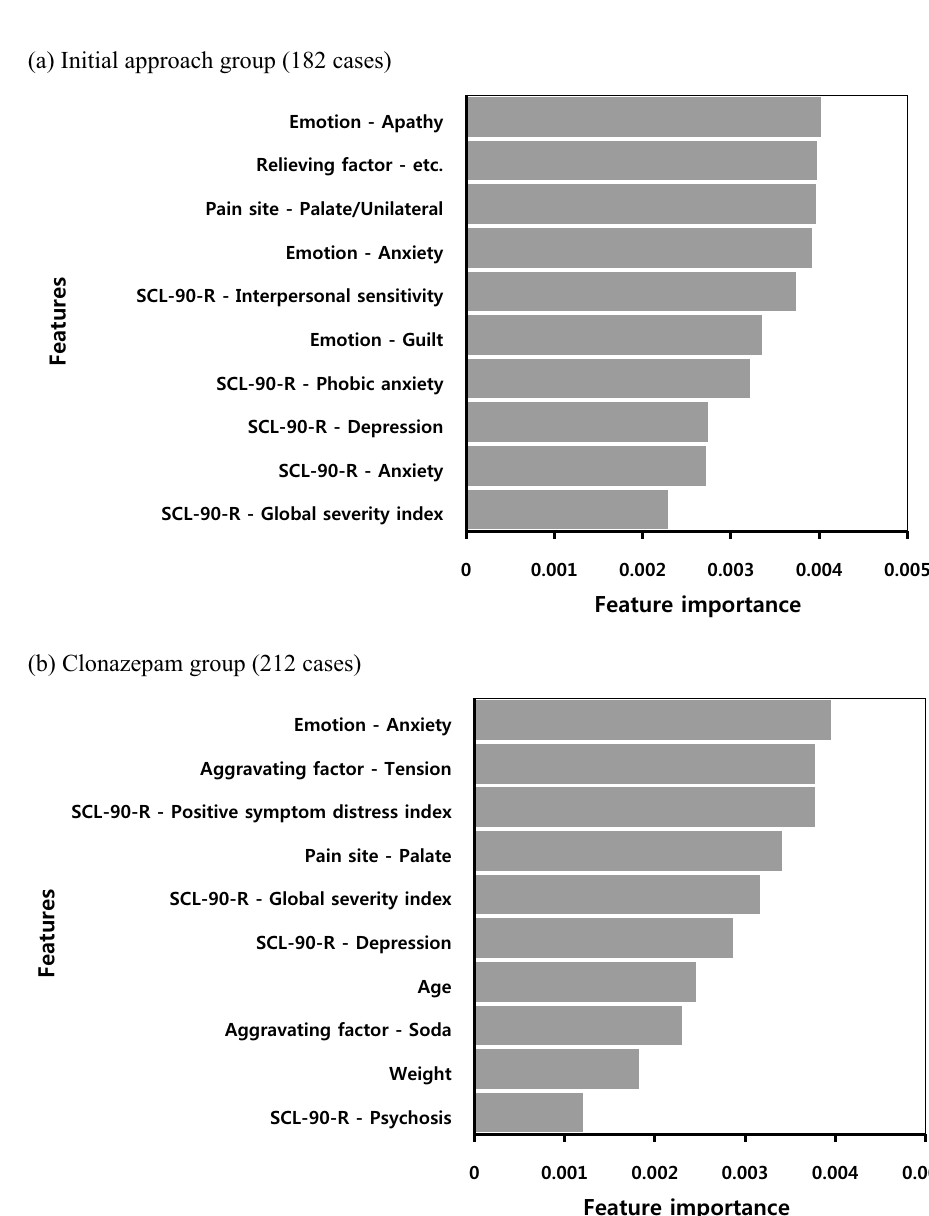
Figure 3. Lower 10 feature importance for prediction models of ( a ) the initial approach and ( b ) clonazepam group datasets. SCL-90-R, Symptom